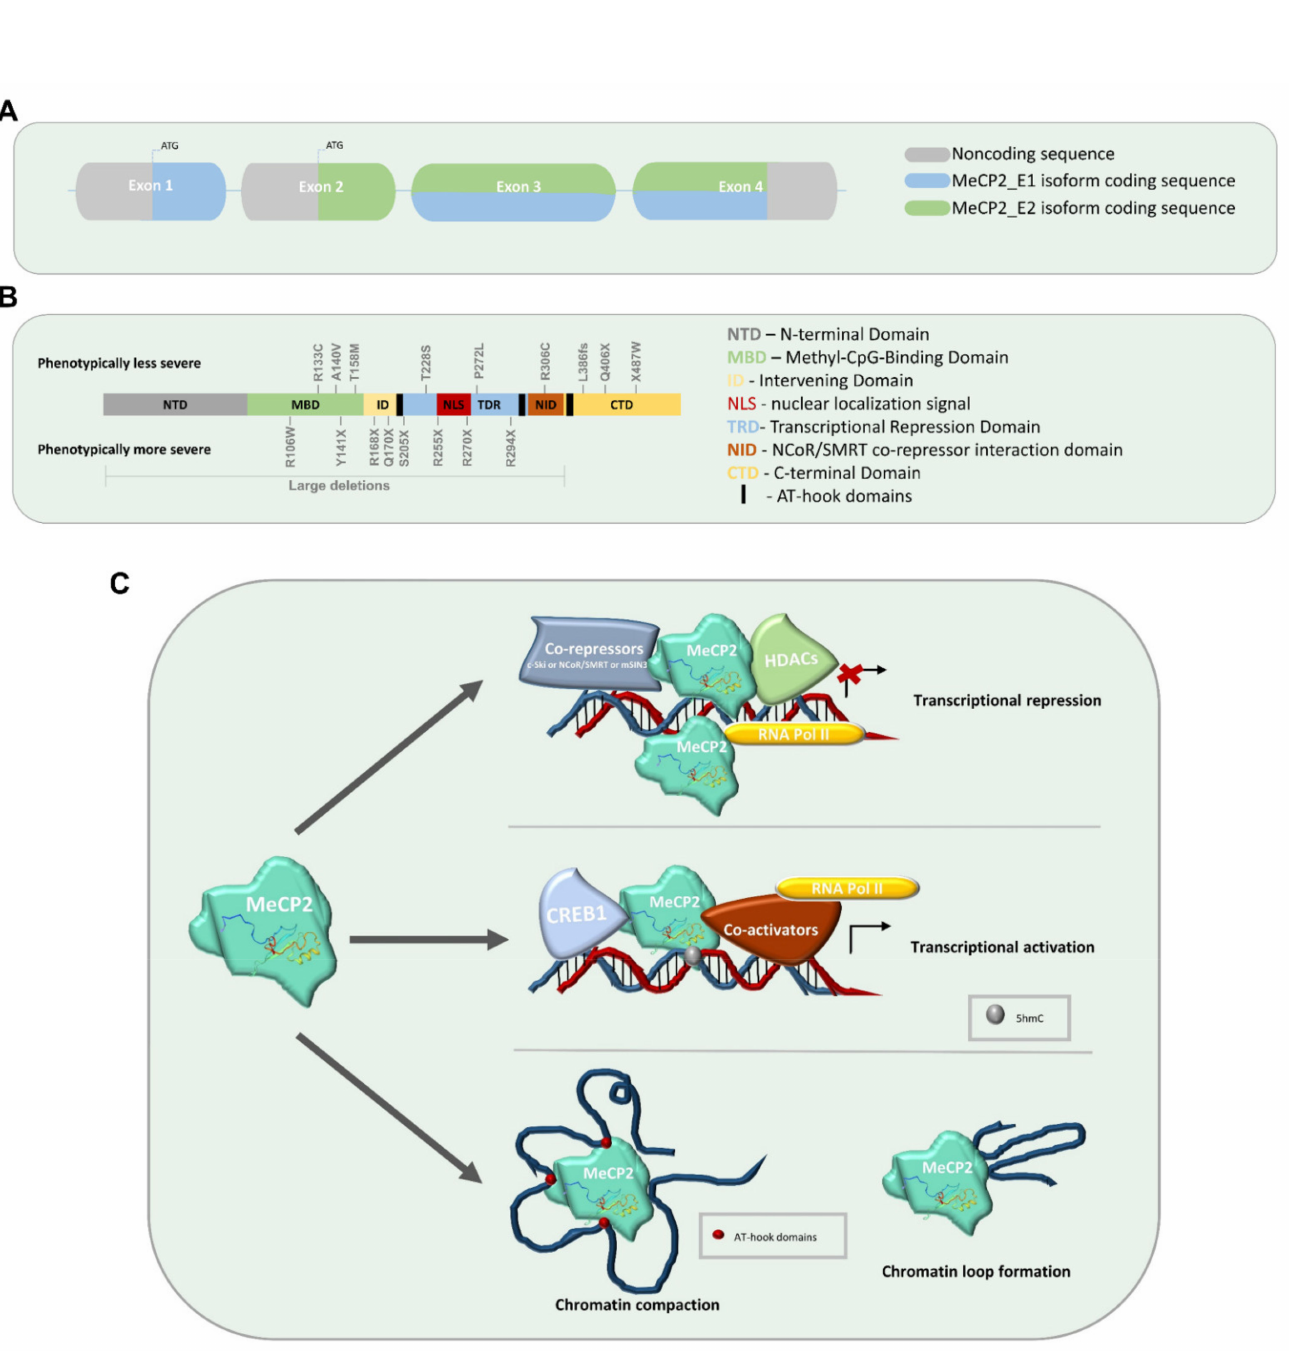
Figure 1. ( A ) Schematic view of the MeCP2 gene structure. The figure shows a representative structure of the four exons that constitute the MeCP2 gene, and the respective isoform coding sequence for each MeCP2 proteins isoforms, MeCP2_E1 and MeCP2_E2. ( B ) Schematic representation of MeCP2 protein domains. Each domain is annotated with the more common and frequent mutations found in the public database http://mecp2.chw.edu.au (accessed at 10 March 2021). On the upper part are annotated the mutations associated with milder phenotypes, while in the bottom are mutations associated with the more severe phenotypes of RTT. ( C ) Schematic view of the major roles of MeCP2. MeCP2 is capable of repressing or activating the transcription of several target genes, recruiting co-repressors and co-activators. Some known co-repressors are c-Ski, N-CoR/SMRT and mSIN3A. MeCP2 also represses the rate of RNA polymerase (Pol II) transcription initiation. One known mechanism of MeCP2 gene activation is through direct binding to CREB1. MeCP2 also induces transcriptional modifications by altering chromatin conformation and by promoting the formation of the chromatin